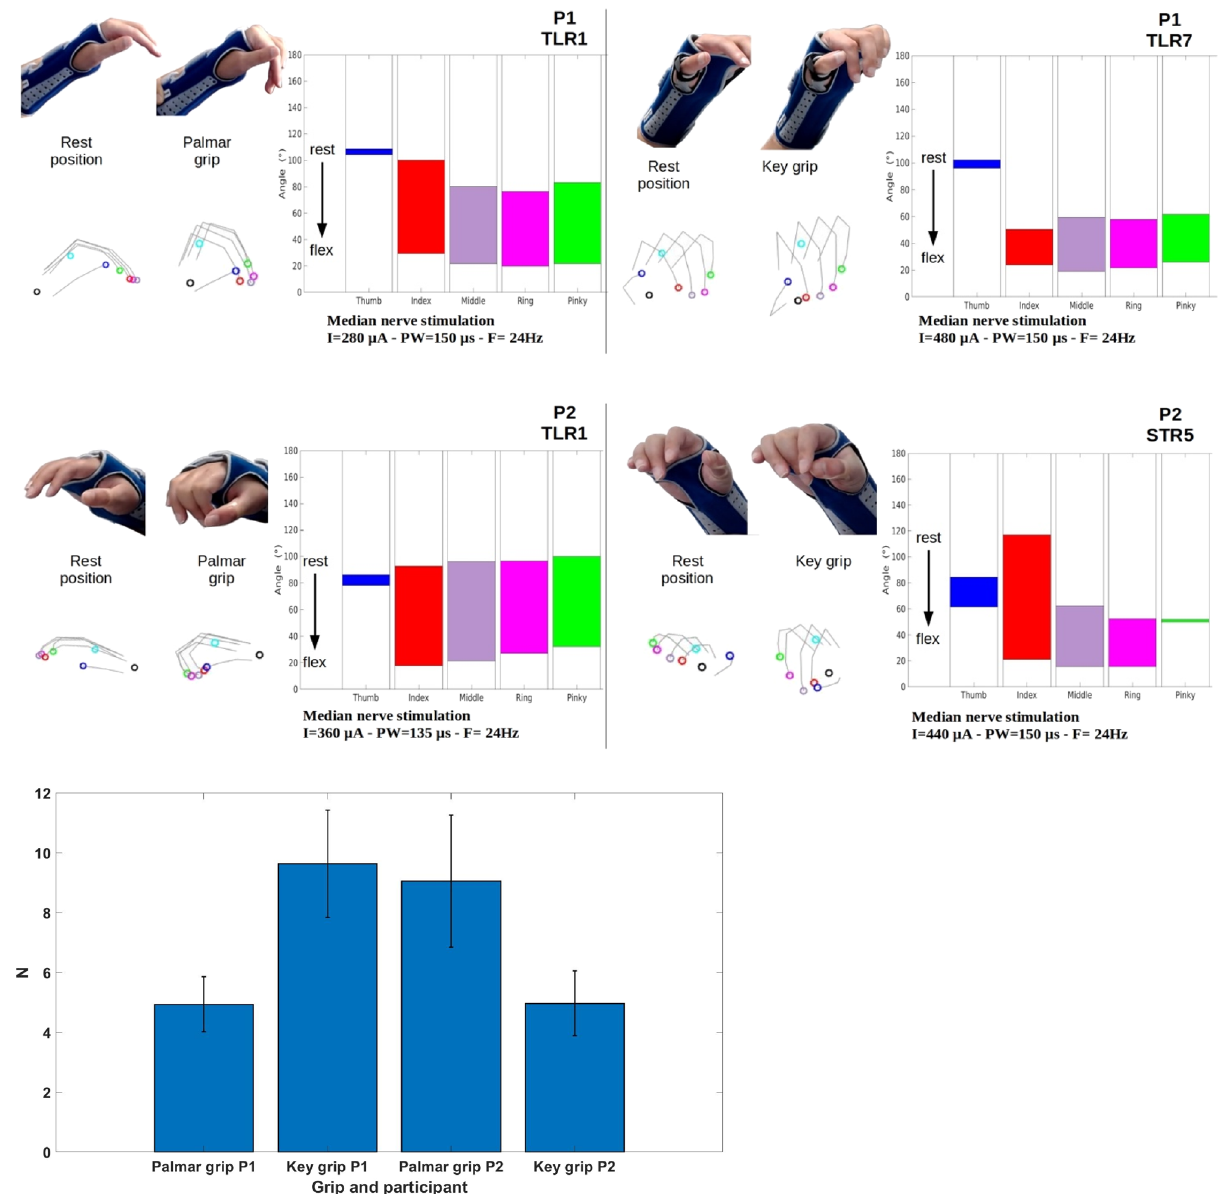
Figure 4. Kinematics data of palmar grip with thumb and key grip. Top: Participant P1 (Left: Configuration TLR1, Right: Configuration TLR7). Middle: Participant P2 (Left: Configuration TLR1, Right: Configuration STR5). Video snapshots and posture reconstruction based on Leap Motion data. The diagrams represent the excursions of the 5 angles. Bottom: Normal forces recorded for Palmar (instrumented can) and Key grip (instrumented tablet) for P1 and P2, 3 trials per condition.